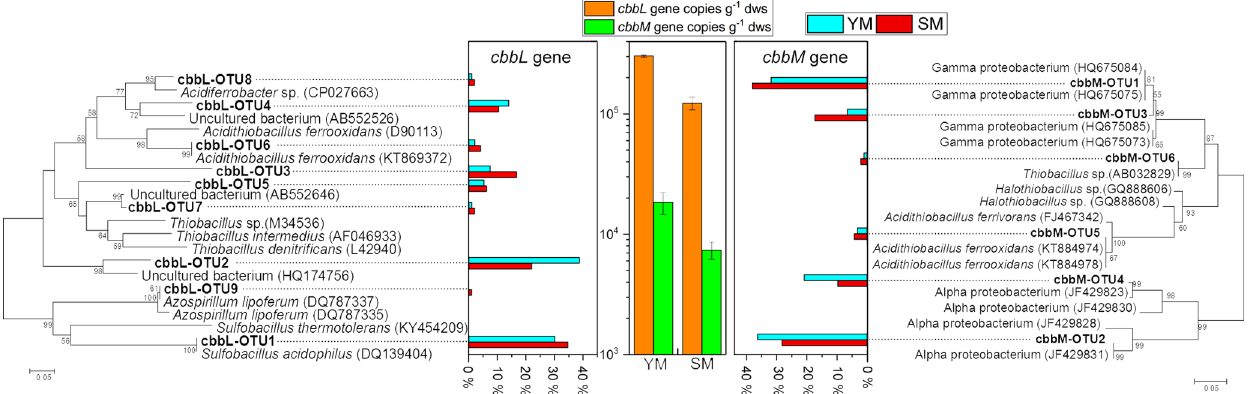
Figure 6. Phylogenetic tree of translated cbbL and cbbM sequences in the heavy fractions from YM and SM treated with FeS 2 . Relative frequencies (%) are marked in the bar graph. Bootstrap values of > 50% are indicated at branch points. cbbL and cbbM gene copy numbers in the heavy fractions from FeS 2 -treated YM and SM are shown in the middle of the figure. The cultured genera most related to OTUs from cbbL and cbbM clone libraries are shown in Table